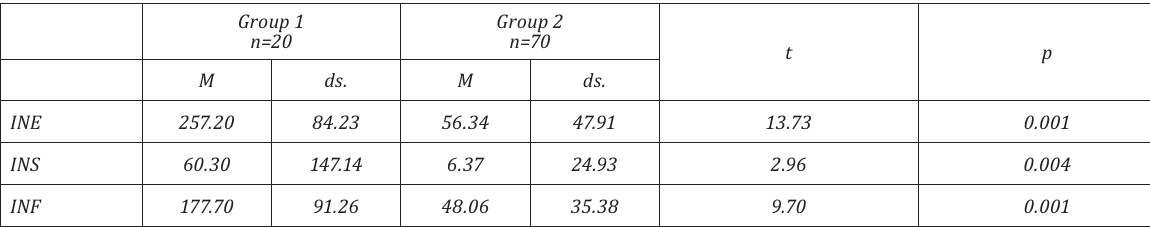
Table 1. Average indices of emotional (INE), sexual (INS) and physical abuse (INF) in separate groups of people with alcohol dependence